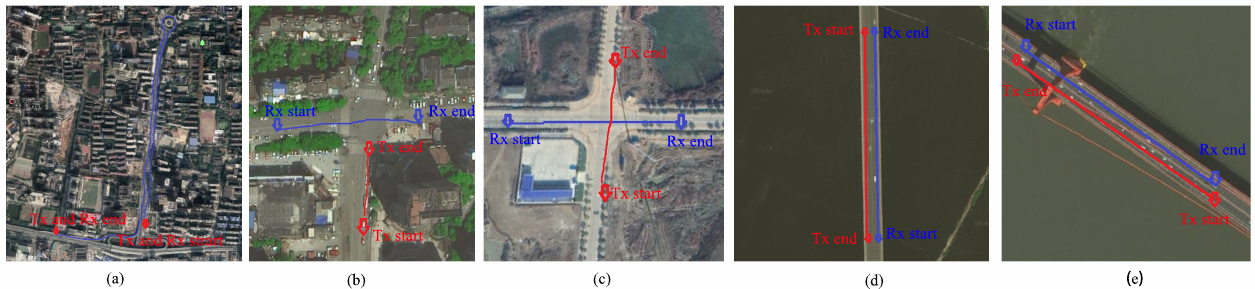
Figure 4. Satellite snapshot of the measured scenarios: ( a ) car-following scenarios in a dense urban area, ( b ) intersection in an urban area, ( c ) intersection in a rural environment, ( d ) suspension bridge, and ( e ) beam